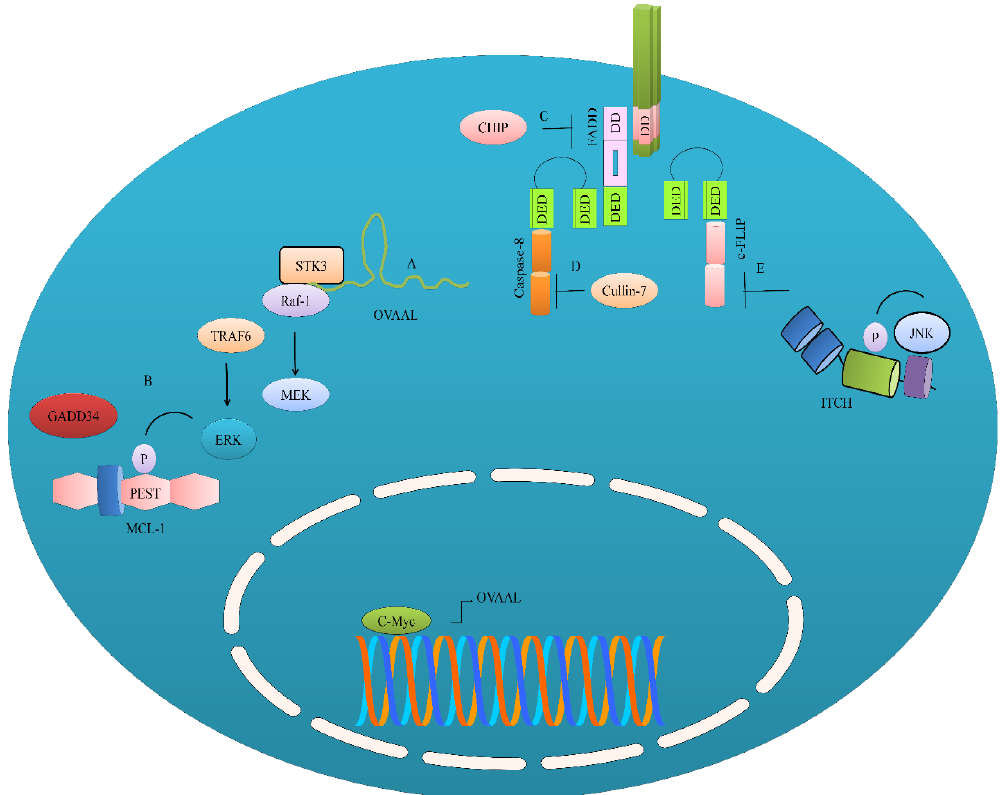
Figure 2. Negative regulation of the TRAIL-driven pathway. ( A ) OVAAL, a long non-coding RNA, has been shown to promote interaction between STK3 and Raf-1. STK3 and Raf-1 work synchronously and activate the MEK / ERK pathway; ( B ) ERK has also been shown to stabilize MCL-1. ERK is also activated by TRAF6 and GADD34 to stabilize MCL-1. OVAAL is transcriptionally upregulated by c-Myc; ( C ) Post-translational modifications have been shown to e ff ectively regulate caspase-8 and FADD. FADD is negatively regulated by C terminus HSC70-interacting protein (CHIP); ( D ) Caspase-8 is negatively regulated by Cullin-7; ( E ) ITCH involved in the negative regulation of c-FLIP.